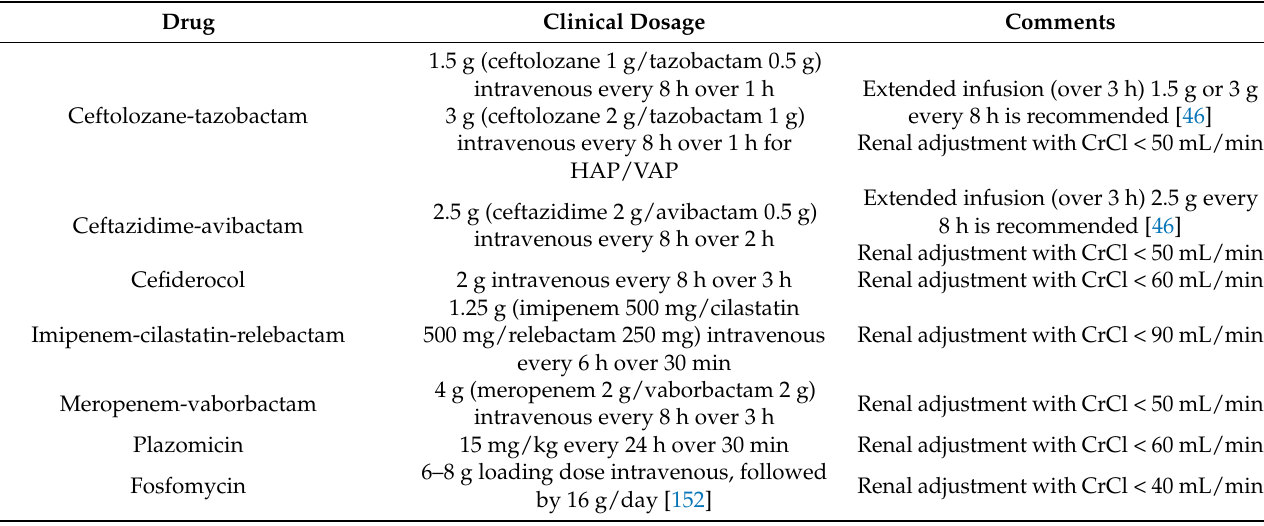
Table 2. Clinical dosage and renal adjustment for anti-pseudomonal agents. Drug Clinical